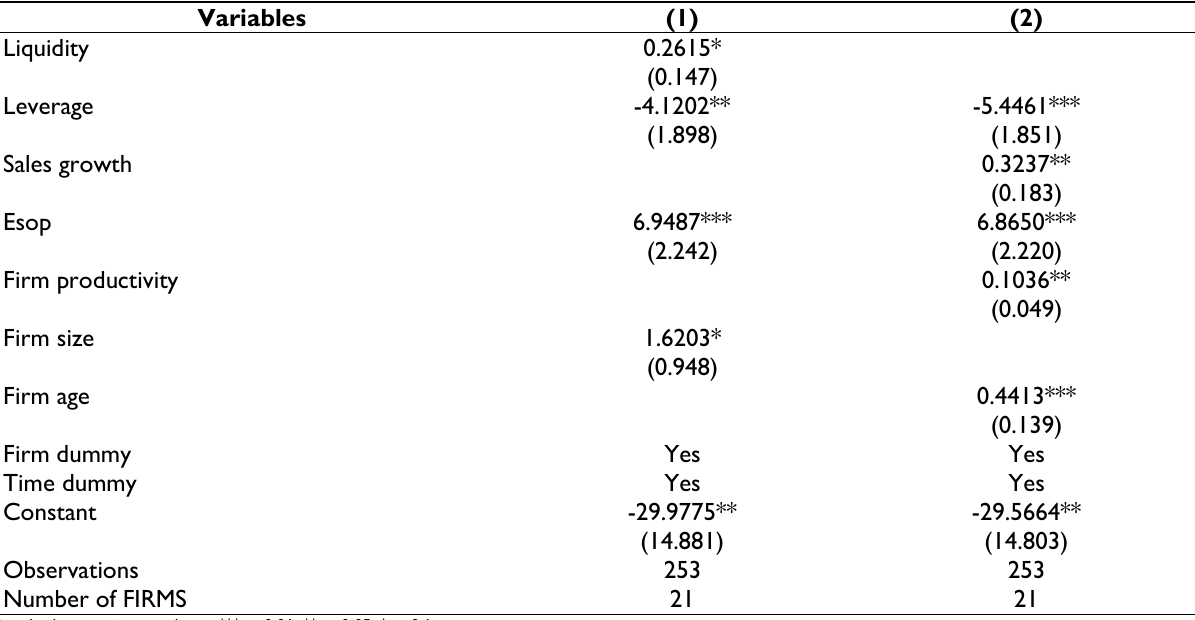
Table 7 Baseline Random Effect Model on ESOP And